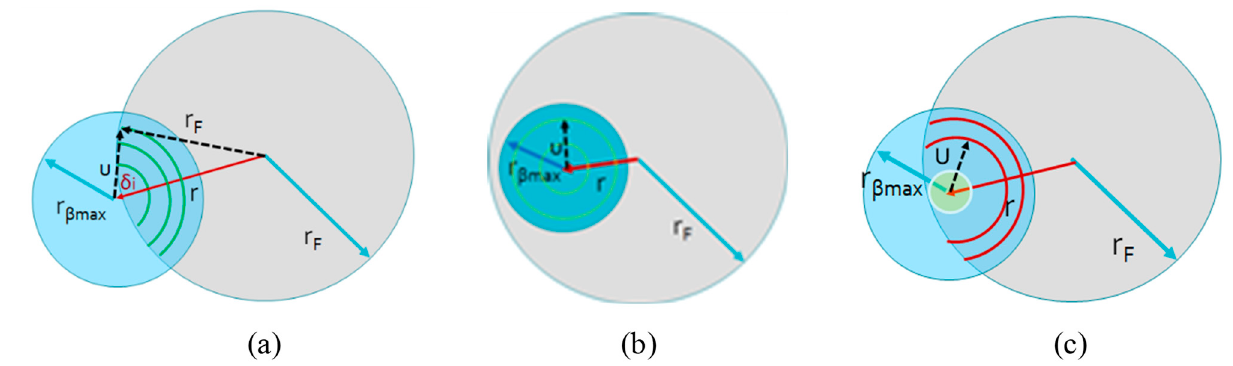
Figure 2. Types of integrations over ( a ) only arcs, ( b ) only circumferences, ( c ) circumferences and arcs.